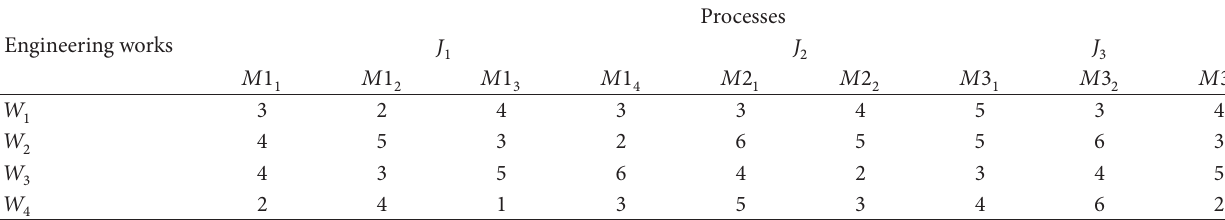
Table 1: Example of scheduling engineering personnel